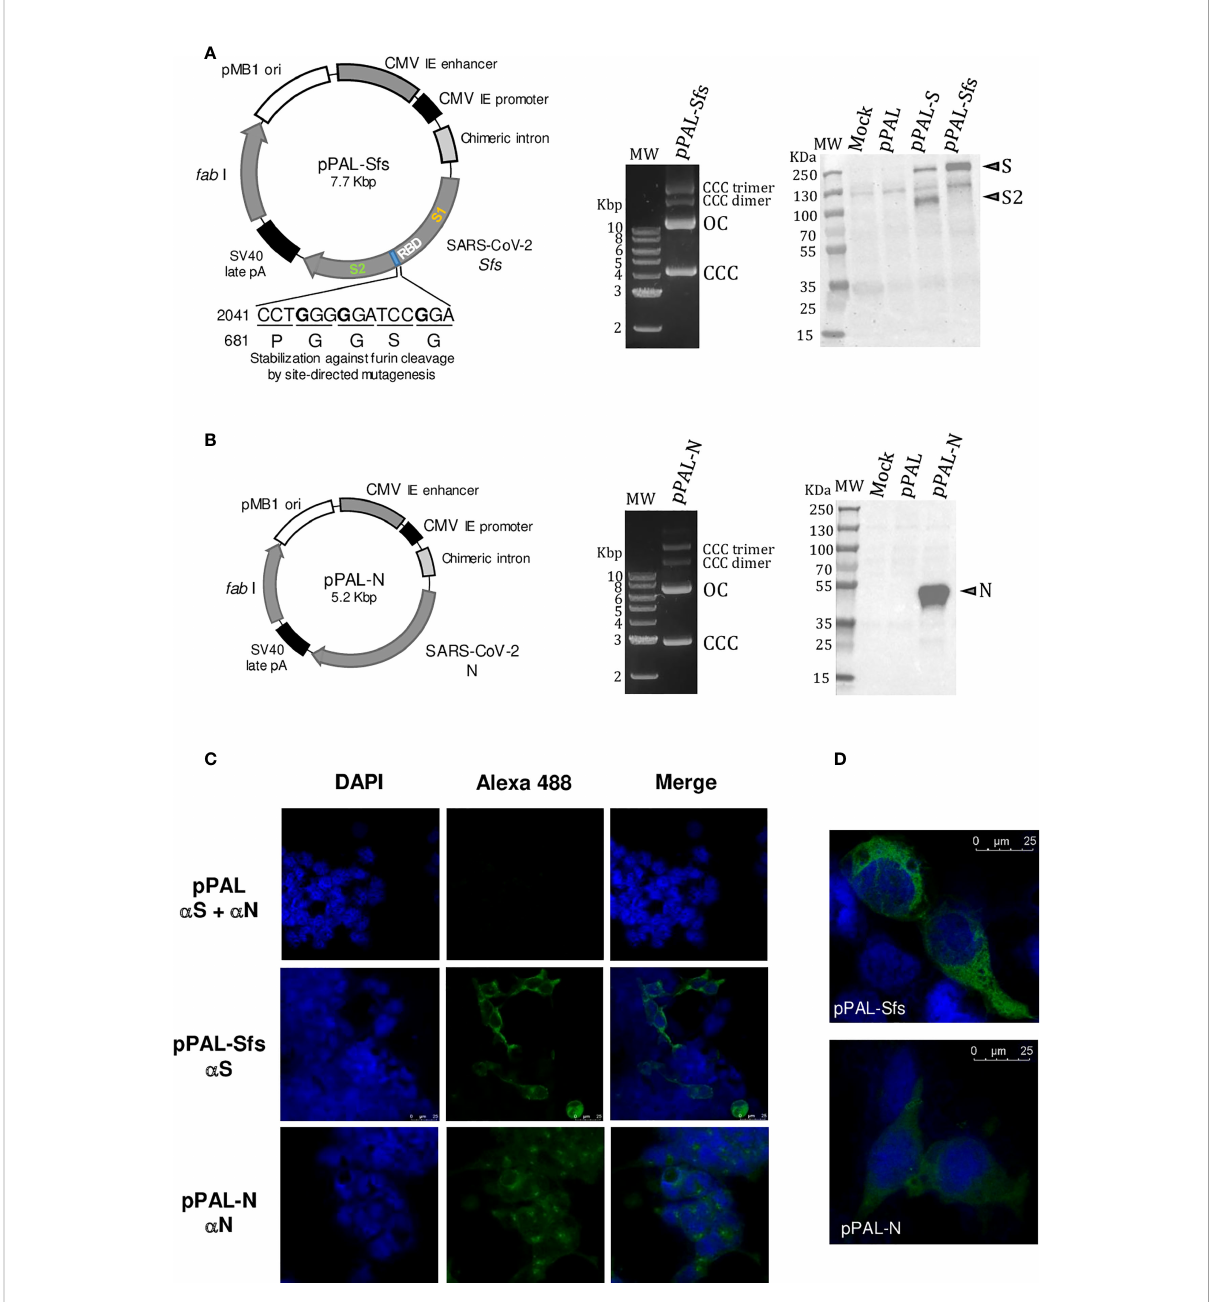
FIGURE 1 The pPAL-Sfs + pPAL-N vaccine candidate. (A) pPAL-Sfs map. Sfs is a codon-optimized modi fi ed version of the SARS-CoV-2 Wuhan reference sequence that contains a modi fi cation to avoid furin cleavage of the protein product. Large-scale laboratory preparation of the pPAL-Sfs plasmid containing supercoiled (CCC), open-circular (OC), CCC-dimer, and CCC-trimer conformers. Western blot of whole protein extracts from HEK293 cells transfected with pPAL, pPAL-S, and pPAL-Sfs. The primary antibody was 1:800-diluted goat anti-S polyclonal antibody (Abcam #ab272504, Cambridge, United Kingdom), which only recognizes the S2 subunit. The secondary antibody was 1:2,000-diluted HRP-conjugated goat polyclonal anti-rabbit Ig. Furin cleaves the S protein obtained from pPAL-S but not Sfs from pPAL-Sfs. (B) Large-scale laboratory preparation of the pPAL-N plasmid containing CCC, OC, CCC-dimer, and CCC-trimer conformers. Western blot of whole protein extracts from HEK293 cells transfected with pPAL and pPAL-N. The primary antibody was 1:500-diluted rabbit anti-N polyclonal antibody. The secondary antibody was 1:2,000-diluted HRP-conjugated goat polyclonal anti-rabbit Ig. (C, D) immuno fl uorescence of cultured HEK293 cells transfected with pPAL, pPAL-Sfs, and pPAL-N plasmids. The anti-S and anti-N antibody dilutions were 1:50. The pPAL control was incubated with both antibodies. The secondary antibody was Alexa Fluor ® 488-conjugated goat anti-rabbit IgG diluted to 1:200. Sfs and N expression is